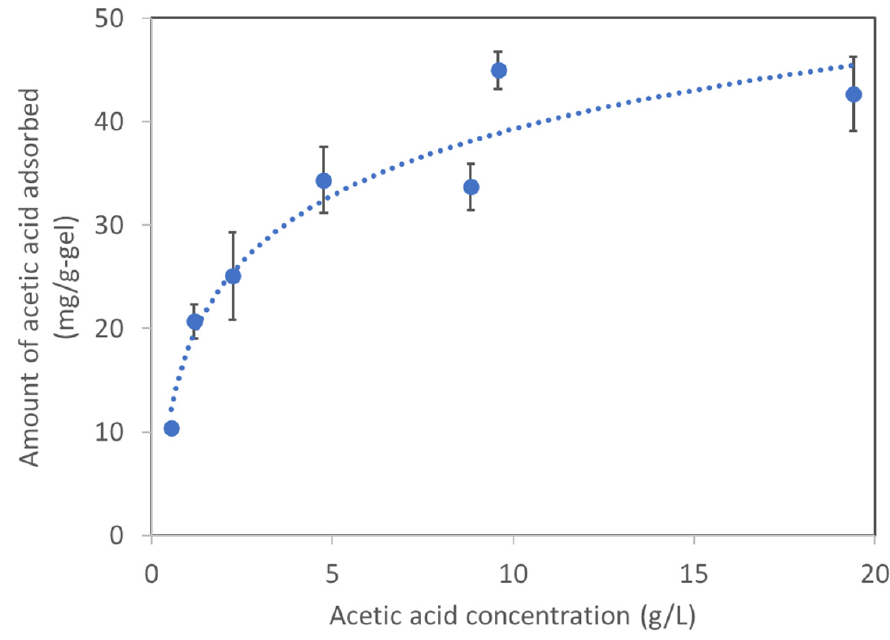
Figure 2. Adsorption isotherm of AQ11 against various concentrations of acetic acid at pH 7.0.